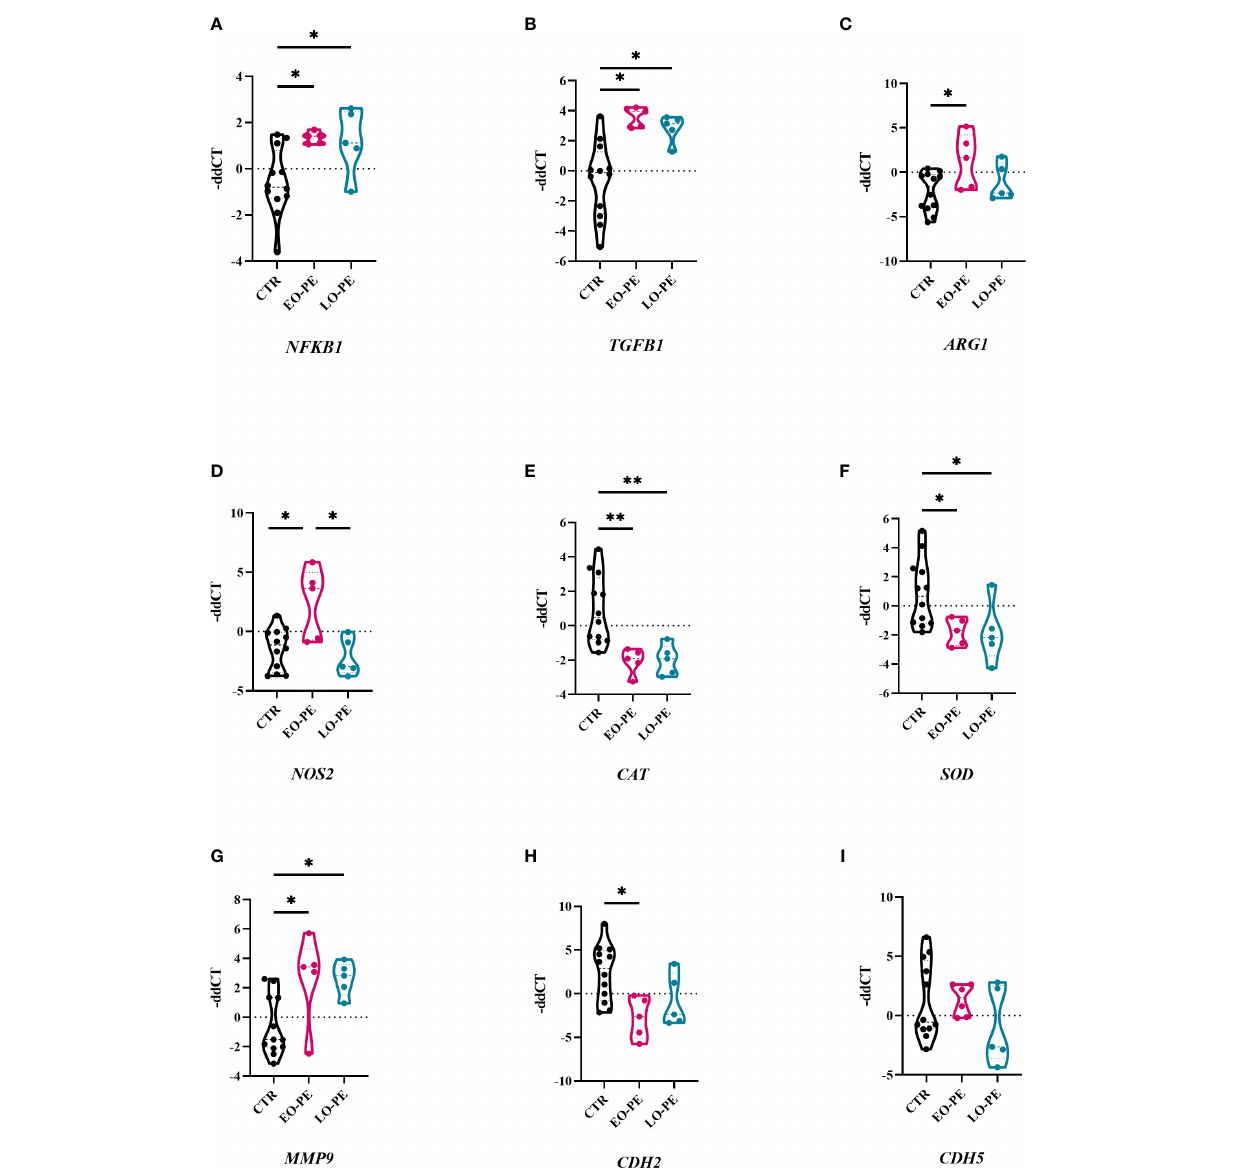
FIGURE 3 Preeclampsia alters in fl ammatory related gene expression in HBCs. (A) Total RNA of cultivated HBCs was harvested on the fi fth day post isolation and analysed by RT-qPCR. (A) NFKB1 , (B) TGFB1 , (C) ARG1 , (D) NOS2 , (E) CAT , (F) SOD , (G) MMP9 , (H) CDH2 , (I) CDH5 . In total 12 CTR, 5 EO-PE and 5 LO-PE HBCs isolations in three technical replicates were used. Expression of target genes was normalized to the following housekeeping genes ( 18S , RPL30 and HPRT1 ) using 2 DD Ct method. Statistical signi fi cance was tested using ANCOVA with adjustment for gestational age followed by Sidak ’ s post-hoc test. *p ≤ 0.05 and **p ≤